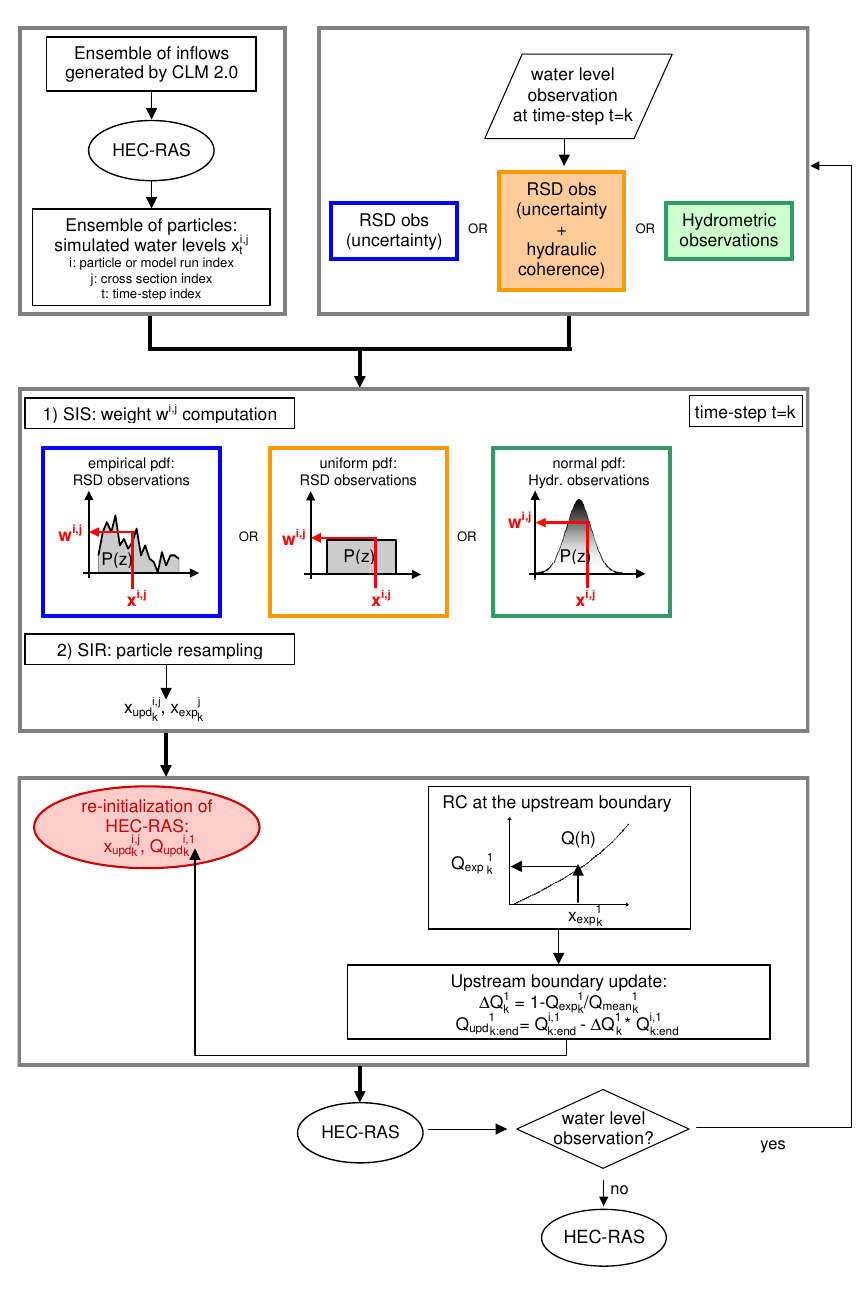
Fig. 4. Flowchart of the data assimilation